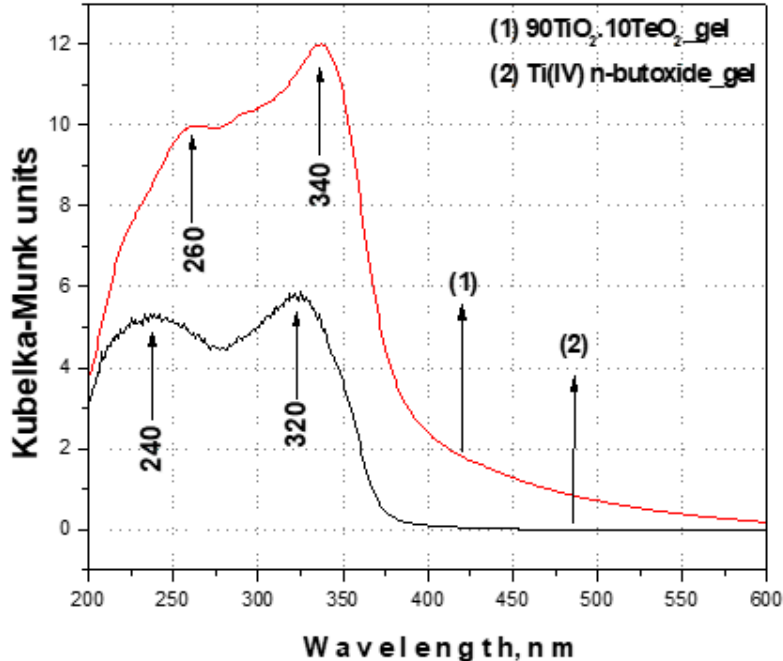
Figure 4. UV-Vis spectra of sample 90TiO 2 .10TeO 2 compared with Ti(IV) butoxide. Table 1. Investigated TiO 2 /TeO 2 gel, observed cut-off and calculated optical band gap values (E g ). - -